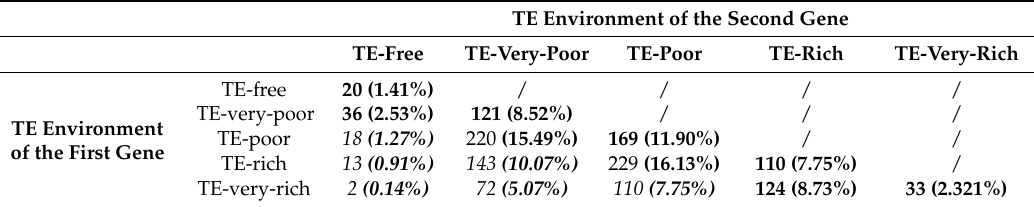
Table 2. Number of gene families according to the TE neighborhood category of each duplicated gene.